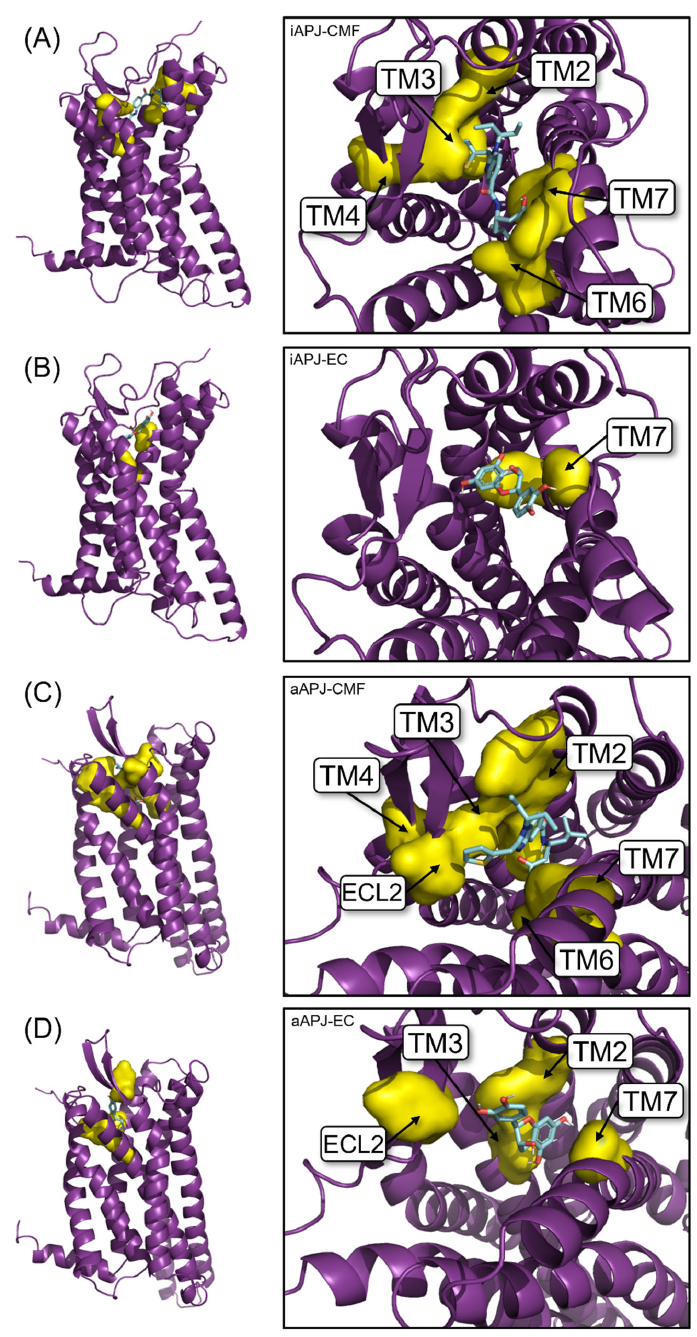
Figure 6. On the left side of each model, the APJ receptor seen from the side is represented in 3D, and on the right, the same receptor, but seen from above. Yellow shows the surface of the residues with which the ligand is in contact, and the arrows indicate the transmembrane domain (TM) to which the residue corresponds. ( A ) The interaction of CMF-019 with the receptor in its inactive conformation: it is observed how the ligand has contact with TM2, 3, 4, 6, and 7. ( B ) The interaction of (-)-epicatechin with the receptor in its inactive conformation: it is observed how it only has contact with the TM7. ( C ) The interaction of CMF-019 with the receptor in its active conformation: it is observed how the ligand has contact with TM2, 3, 4, 6, and 7, and with the extracellular loop (ECL) 2. ( D ) The interaction of (-)-epicatechin with the receptor in its active conformation: it is observed how it has contact with the TM2, 3 and 7, and with the